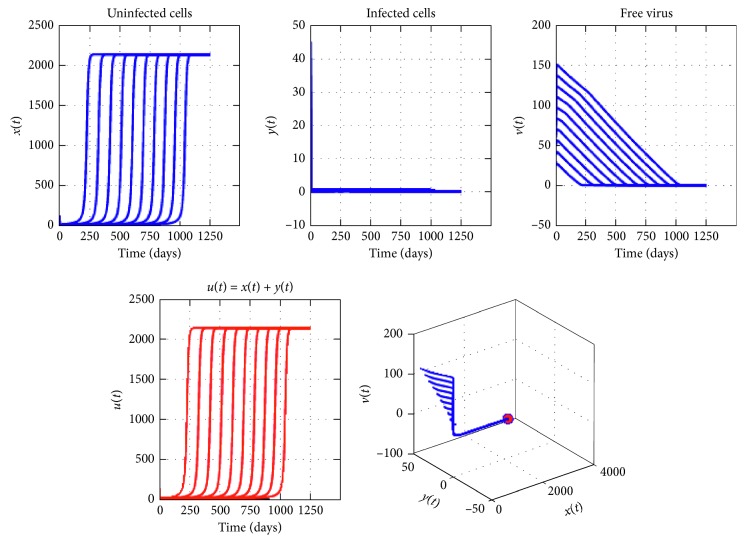
Dynamics of virotherapy when R0=1,5, β0=10−5, β1=10−4, and τ=τ∗=8.8368. The initial conditions are x(0)=127, y(0)=0, and v(0)=30.